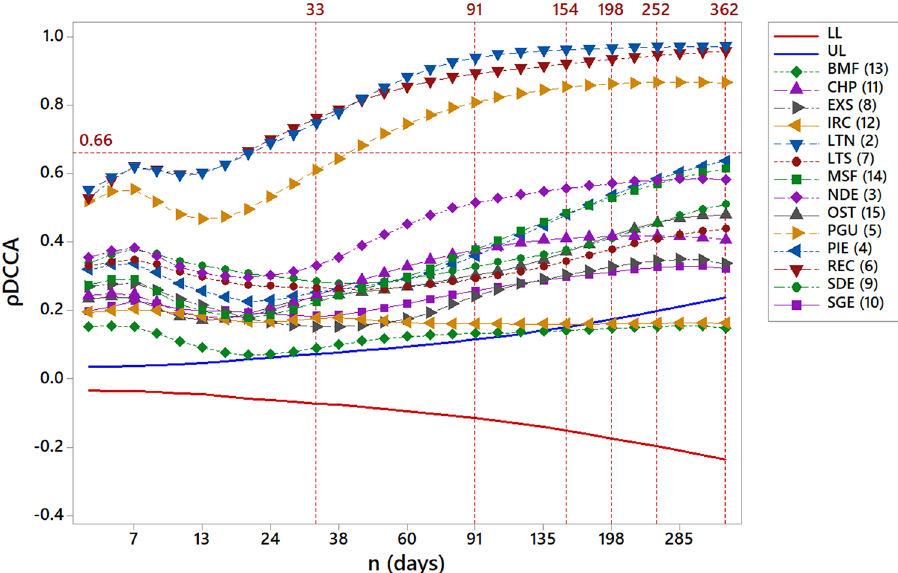
Figure 2. Cross-correlation results for 29 different time scales. The values for ρ DCCA between RMS and the nearby ER presented a strong, significant correlation. LTN, REC and PGU stood out by exceeding the correlation level of 0.66, for the scale of 33 days, remaining strong for all subsequent time scales. LL and UL represent the low and upper limits respectively, and blue line and red line are the significant level values calculated with confidence intervals equal to 95% through the time scales (weeks) 23 . The labels as follows are: economic regions in Bahia, Brazil. The metropolitan region of Salvador (RMS), Litoral Norte (LTN), Nordeste (NDE), Piemonte da Diamantina(PIE), Paraguaçu (PGU), Recôncavo (REC), Litoral Sul (LTS), Extremo Sul (EXS), Sudoeste (SDE), Serra Geral (SGE), Chapada Diamantina (CHP), Irecê (IRC), Baixo Médio São Francisco (BMF), Médio São Francisco (MSF), Oeste (OST).The division was extracted from 24